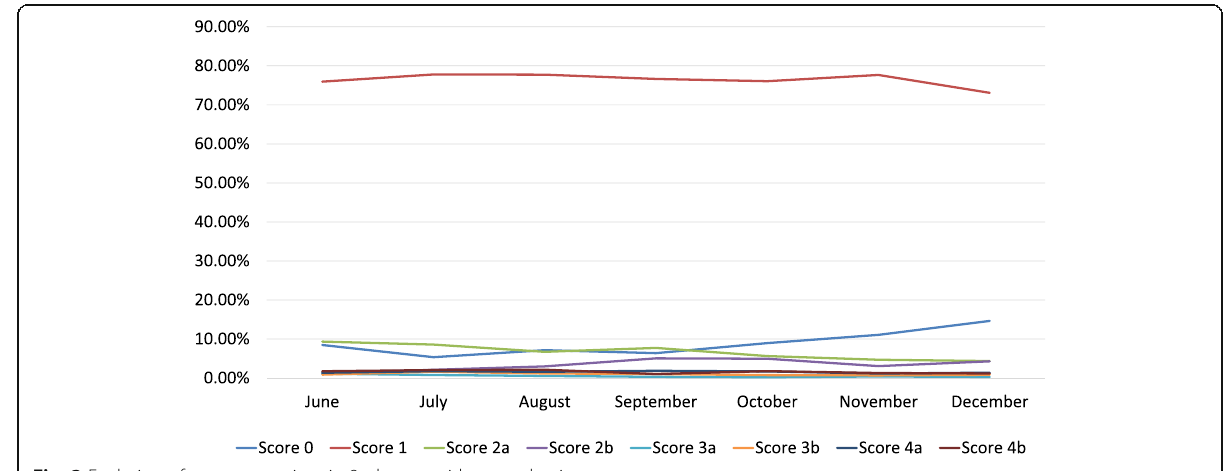
Fig. 3 Evolution of scores over time in 2nd-year residents evaluation